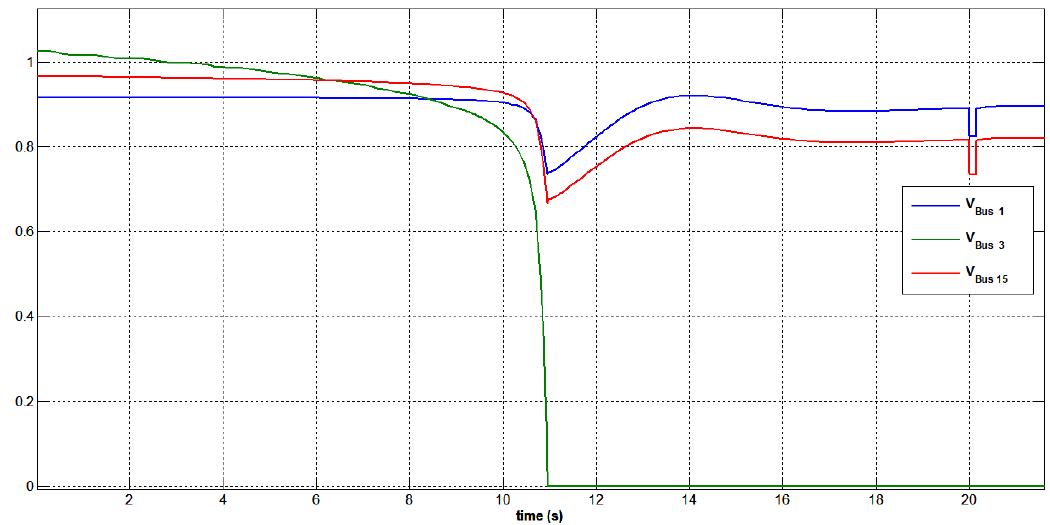
Figure 36. Voltage variation at buses 1, 3, and 15 under three ‐ phase short circuit bus 15.